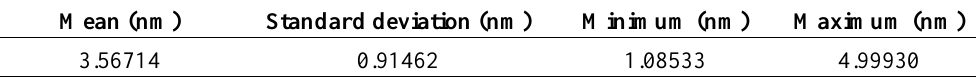
Table 2. Statistical results on the spectral resolution for the 344 FISS channels.